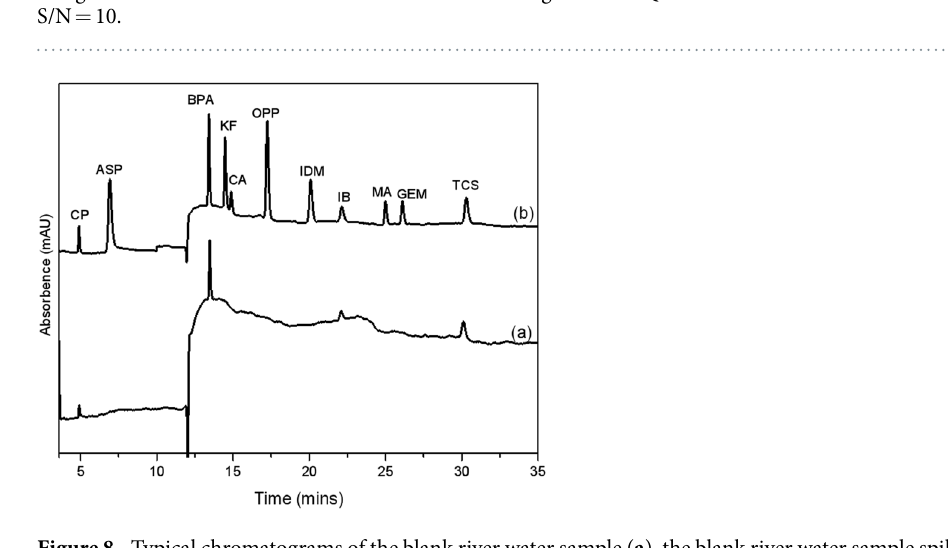
Figure 8. Typical chromatograms of the blank river water sample ( a ), the blank river water sample spiked with 0.1 ng/mL of PPCPs ( b